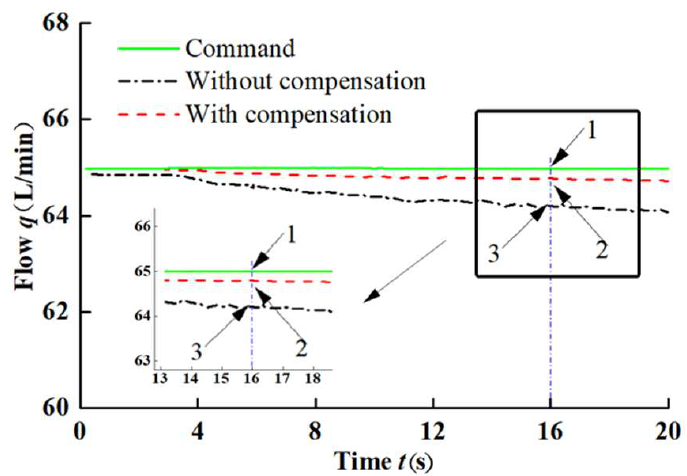
Figure 14. Constant flow characteristics under different pressures.